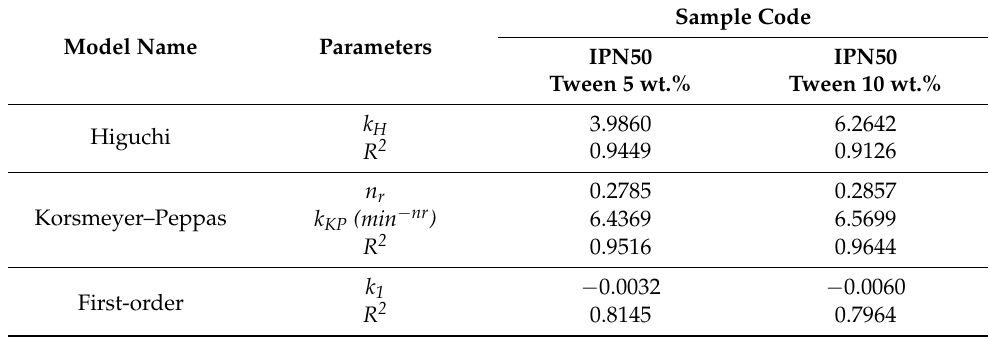
Table 6. Kinetic parameters for the release of CCM from